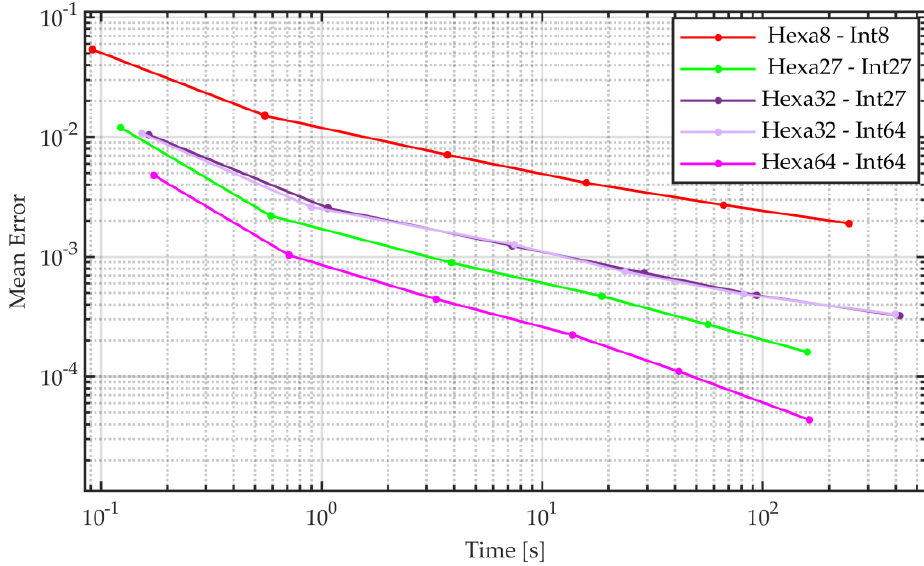
Figure 11. Convergence analysis of cubic serendipity FE formulations as a function of the time for eigenvalue computation in comparison with full − order